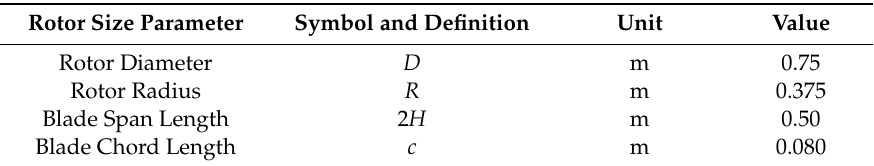
Figure 1. Small straight-bladed vertical axis wind turbine targeted for the computational fluid dynamics (CFD) analysis. Table 1. Rotor size parameters. Table 1. Rotor size parameters.